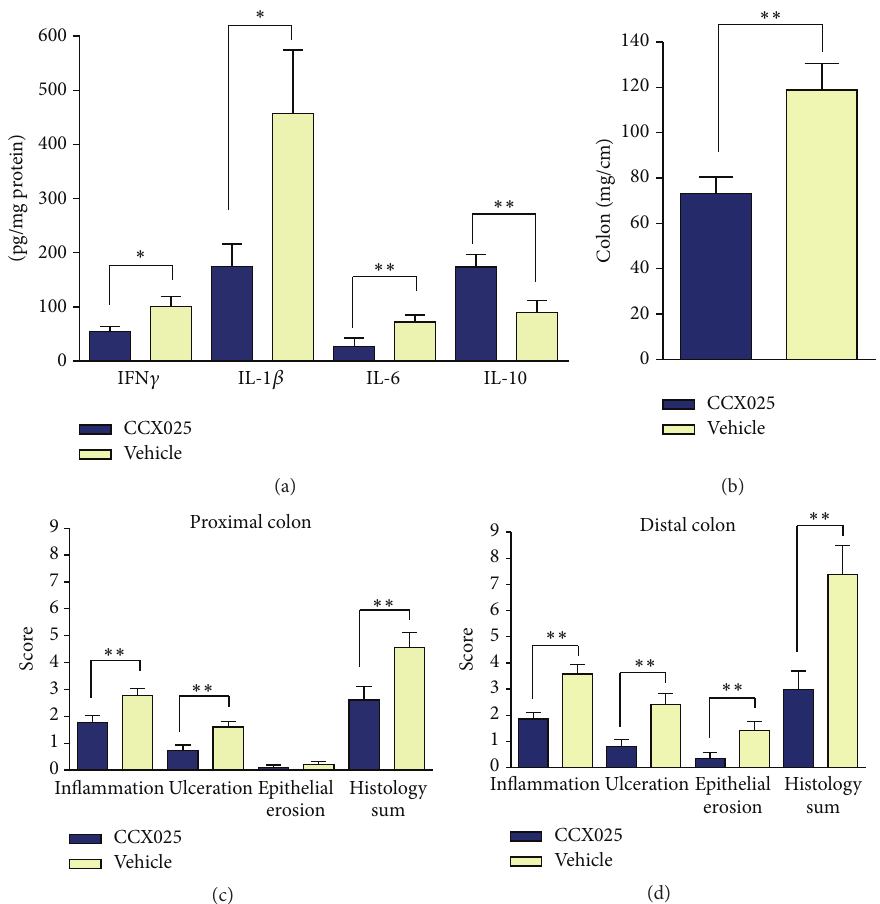
Figure 5: Pharmacological CCR9 inhibition results in a significant improvement in colonic inflammation in mdr1a −/− mice. (a) CCX025 treatment resulted in significantly lower levels of the proinflammatory cytokines IFN- 𝛾 , IL-1 𝛽 , and IL-6 in the colon; at the same time CCX025 treatment resulted in a significant elevation in the levels of the anti-inflammatory cytokine IL-10 in the colon ( 𝑛 = 16–19). (b) CCX025 treatment, starting at 11 weeks of age, resulted in a significant reduction in the weight-to-length ratio of the colon in mdr1a −/− mice, compared to vehicle-treated mice ( 𝑛 = 25 ). CCX025 treatment resulted in significantly reduced histological damage scores in the proximal colon (c) and the distal colon (d). All panels: ∗ 𝑃 < 0.05; ∗∗ 𝑃 <